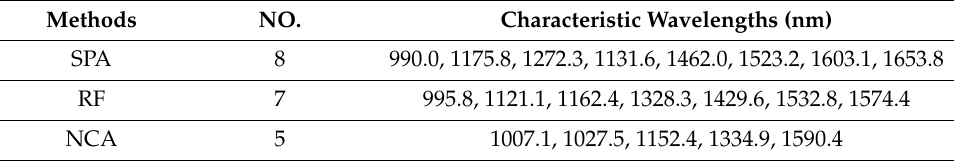
Figure 8. Process of selecting characteristic wavelengths based on neighborhood component analysis (NCA). ( a ) Weight value for each wavelength; ( b ) the relationship between the objective function value and the number of iterations. Table 1. Characteristic wavelength selected based on SPA, RF, NCA.